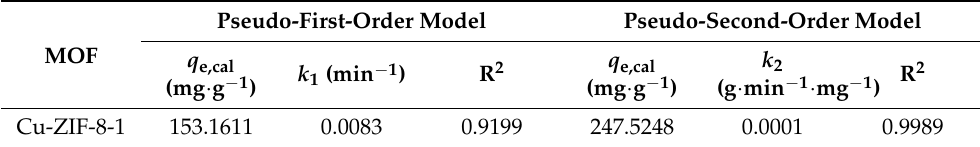
Table 2. Kinetics models parameters of OFX adsorbed on Cu-ZIF-8-1.